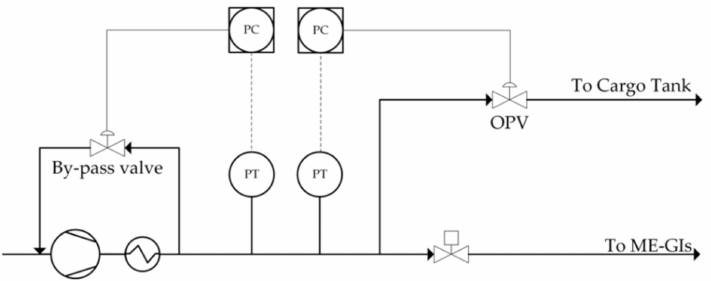
Figure 8. Control configuration for controlling downstream pressure of a BOG